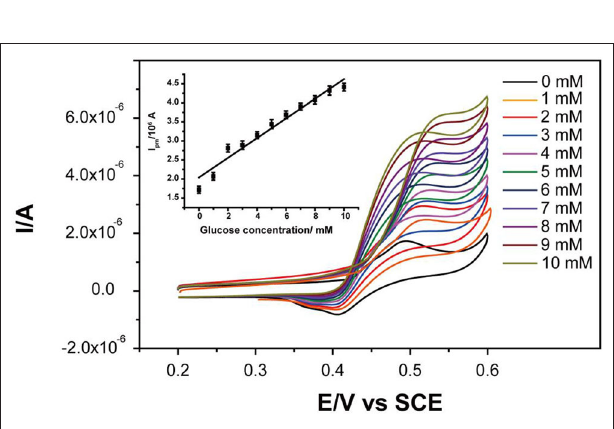
FIGURE 4 | CV curves of Ni-MOFs in the absence and presence of different concentrations of glucose. Inset: the corresponding calibration curve of anodic peak current to glucose concentrations.